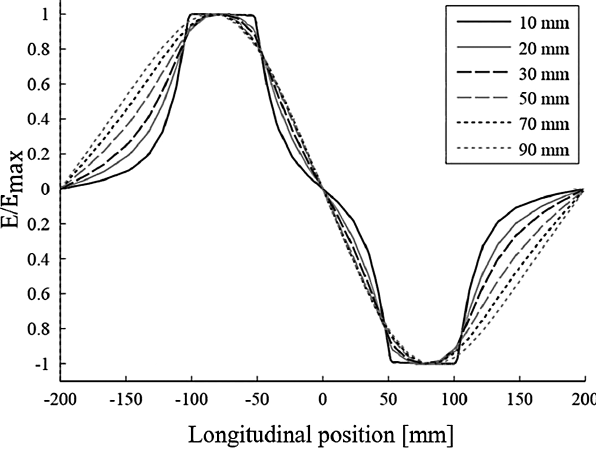
FIG. 4. Fringe transverse electric fields vs longitudinal position for different rod